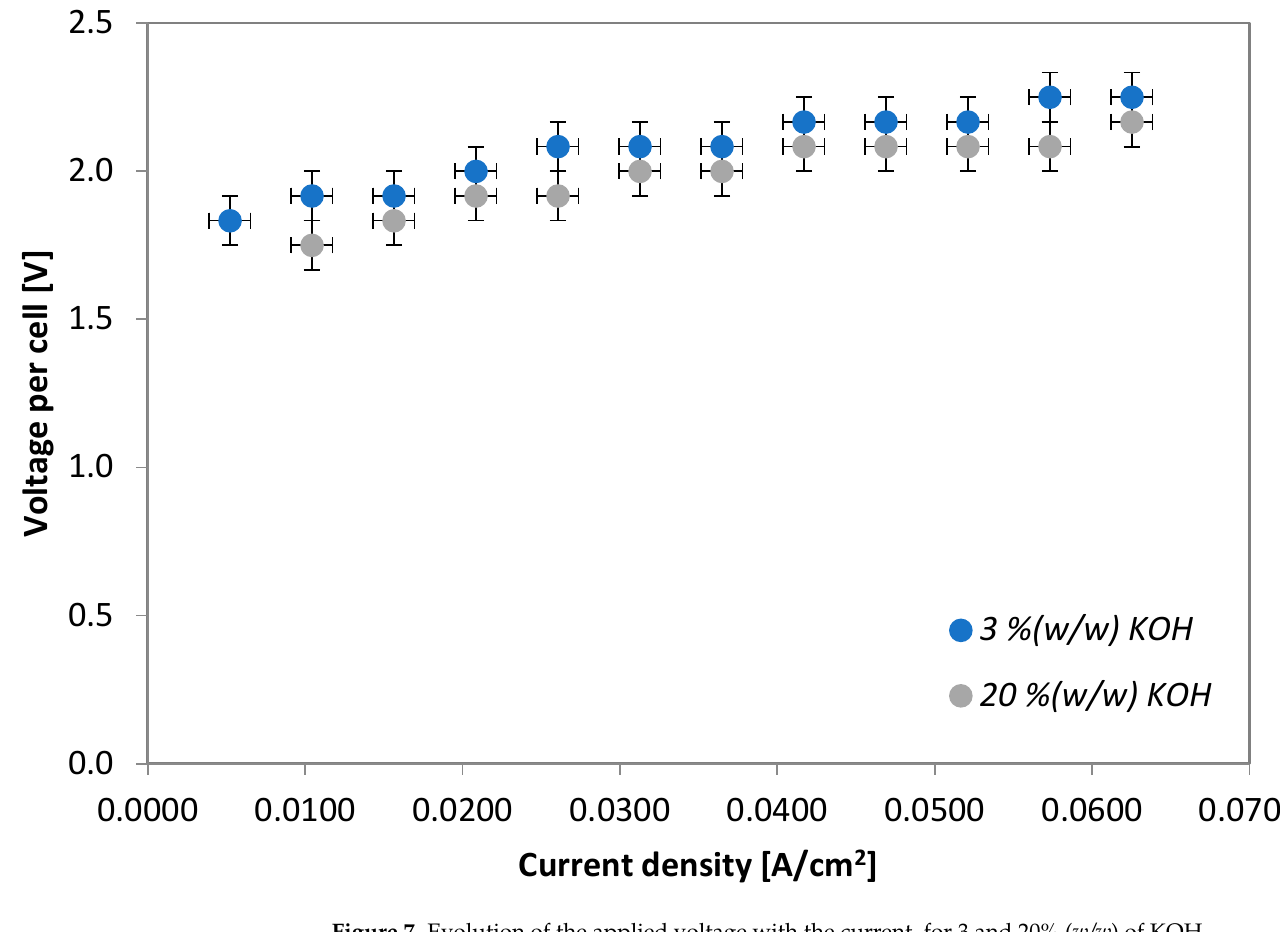
Figure 7. Evolution of the applied voltage with the current, for 3 and 20% ( w/w ) of KOH. It is important to note that the two measurements sets have been performed with different temperatures of the dry cell. Different temperatures will lead to different resistances for the electrodes and electrolyte, so it is not possible to accurately compare the two cases tested. The higher the temperature, the higher the electrical resistance of the electrodes (Equation (21)), and the higher the ionic conductivity of the solution, resulting in a lower ionic resistance, according to the values in [20]. On the other hand, the activation overvoltage in the electrodes also depends on temperature, being, at the outset, lower for higher temperatures since the species have a higher kinetic energy. The same applies to reversible voltage. Thus, it is expected that, for higher temperatures, the applied voltage will be lower. The test for 20% ( w/w ) was performed at a temperature of about 6 ◦ C higher than for the test with 3% ( w/w ) of KOH with lower voltages. In this way, it is difficult to conclude if electrolyte concentration or cell temperature is dominant in influencing the applied cell voltage.